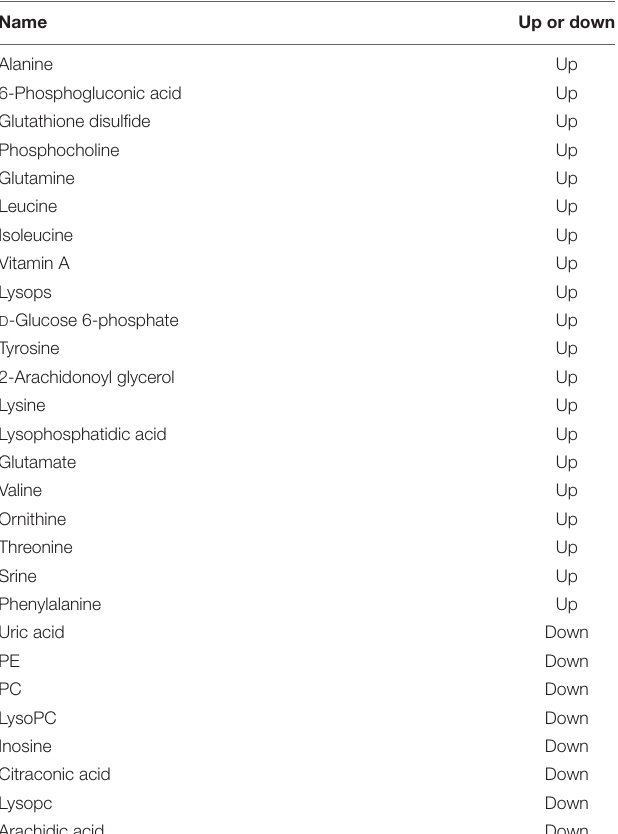
TABLE 4 | Differentially expressed metabolites in the shrimp muscle tissue in response to Axn